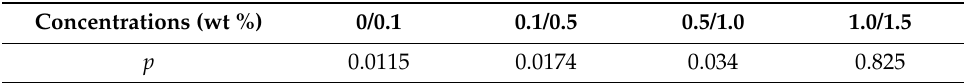
Table 4. Variance analysis for friction coefficients of the base oil with different concentrations of MoO 3 additives.